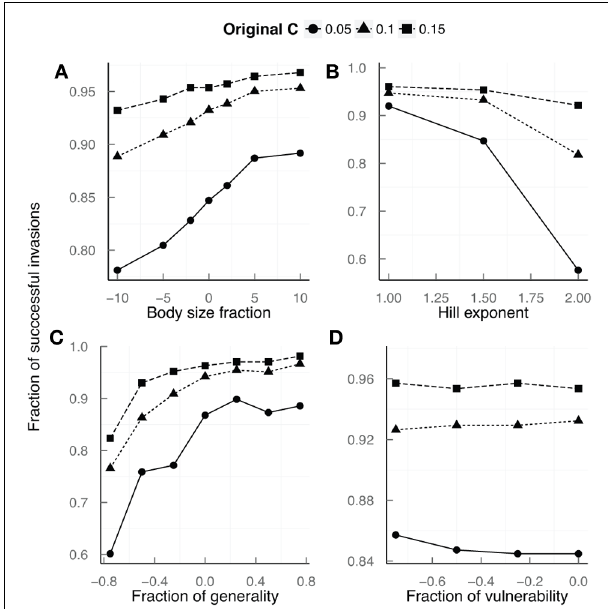
FIGURE 3 | Effects of invader species traits on invasion success measured as the fraction of successful invasions for a given trait value. (A) Body size: values represent species 10 ( − 10 and 10), 5 ( − 5 and 5), and 2 ( − 2 and 2) times smaller ( − ) or bigger ( + ) than the reference value for that species according to the bio-energetic model. (B) Ability of the invasive species to capture prey (Hill exponent). (C) Fraction of generality: fractions represent invasive species with 25% ( − 0.25 and 0.25), 50% ( − 0.5 and 0.5), and 75% ( − 0.75 and 0.75) less ( − ) or more ( + ) prey than the species reference value. (D) Fraction of vulnerability: values represent invasive species with 25% ( − 0.25), 50% ( − 0.5), and 75% ( − 0.75) less predators than the reference. Circles, triangles, and squares correspond to the values of the fraction of invasion success for networks with connectance values of 0.05, 0.1, and 0.15, respectively.